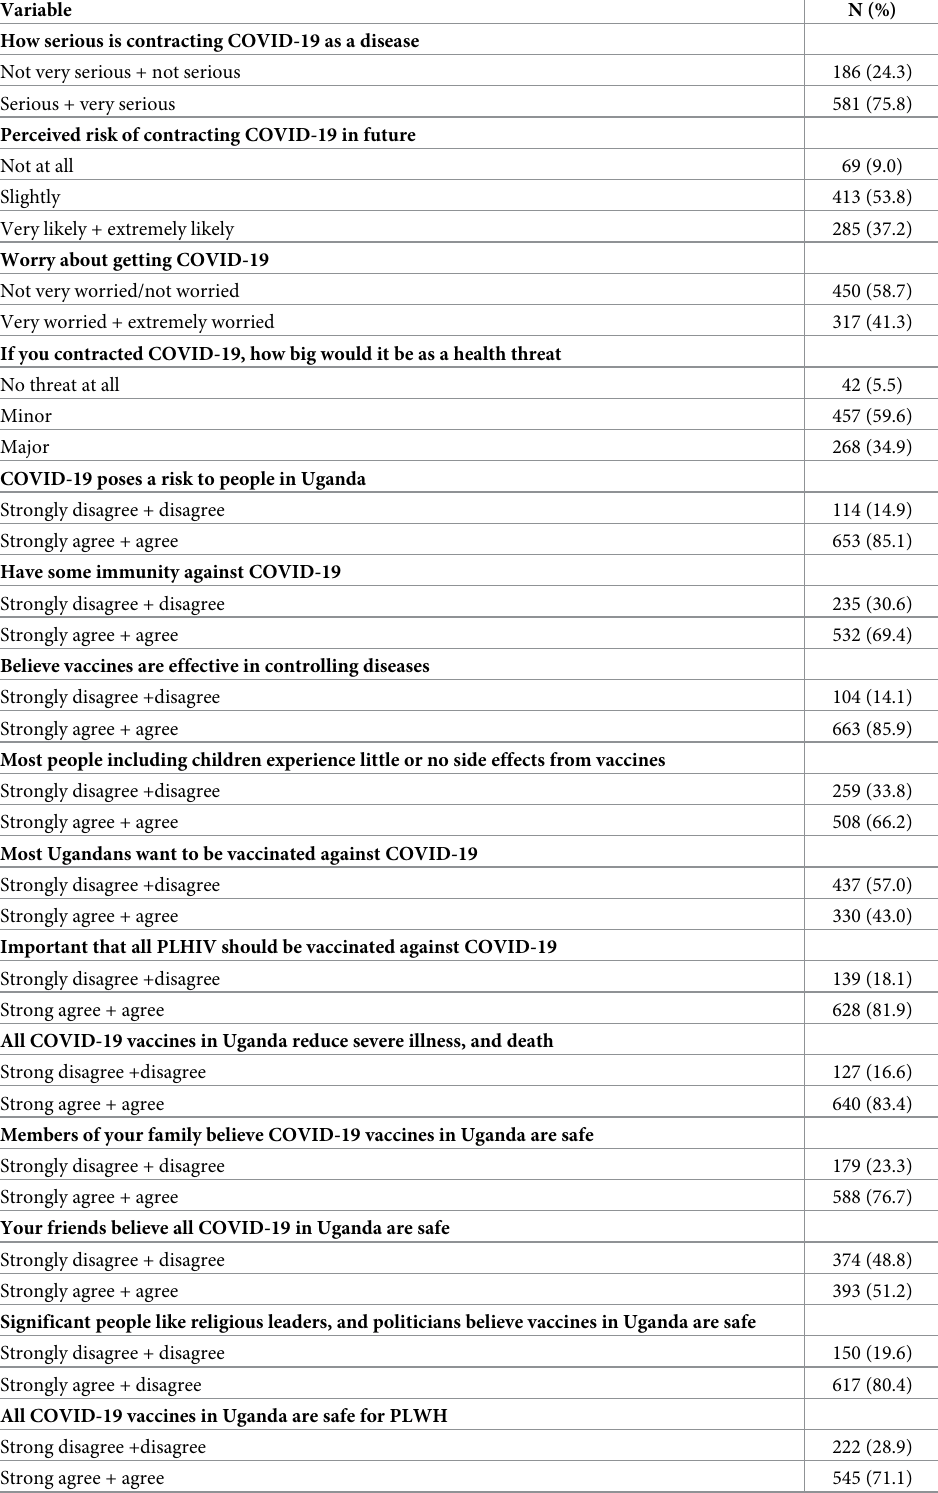
Table 3. Complacency regarding COVID-19 infection, and vaccine